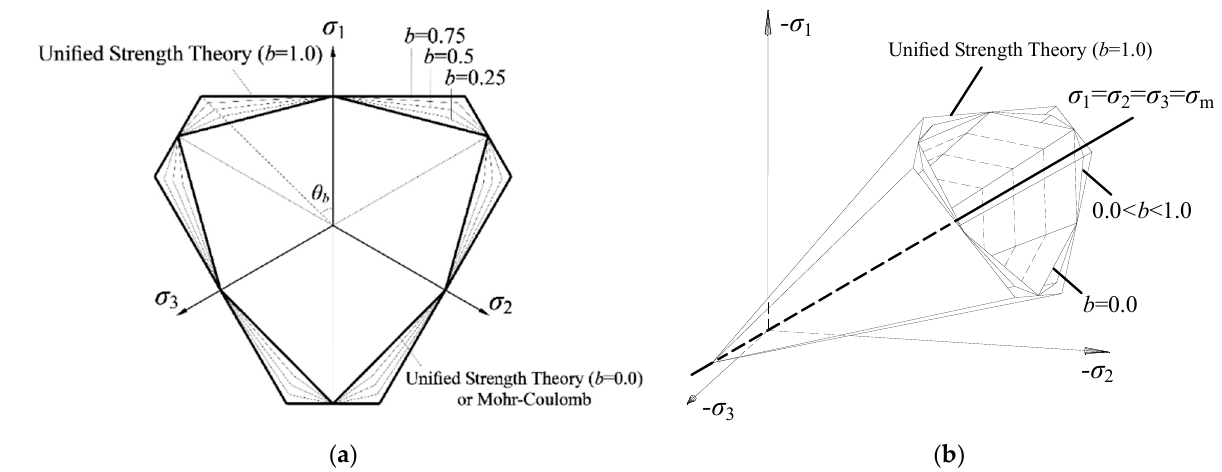
Figure 1. Limit loci of UST: ( a ) deviatoric plane, ( b ) principal stress space.